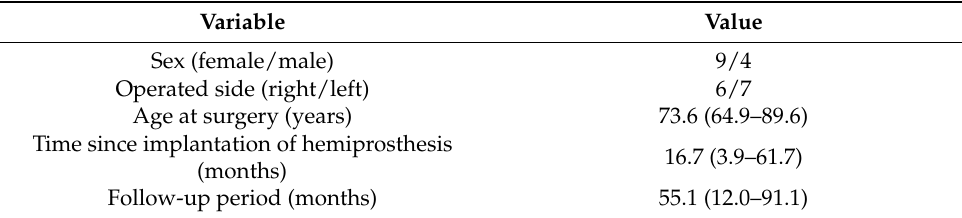
Table 1. Patient demographics and